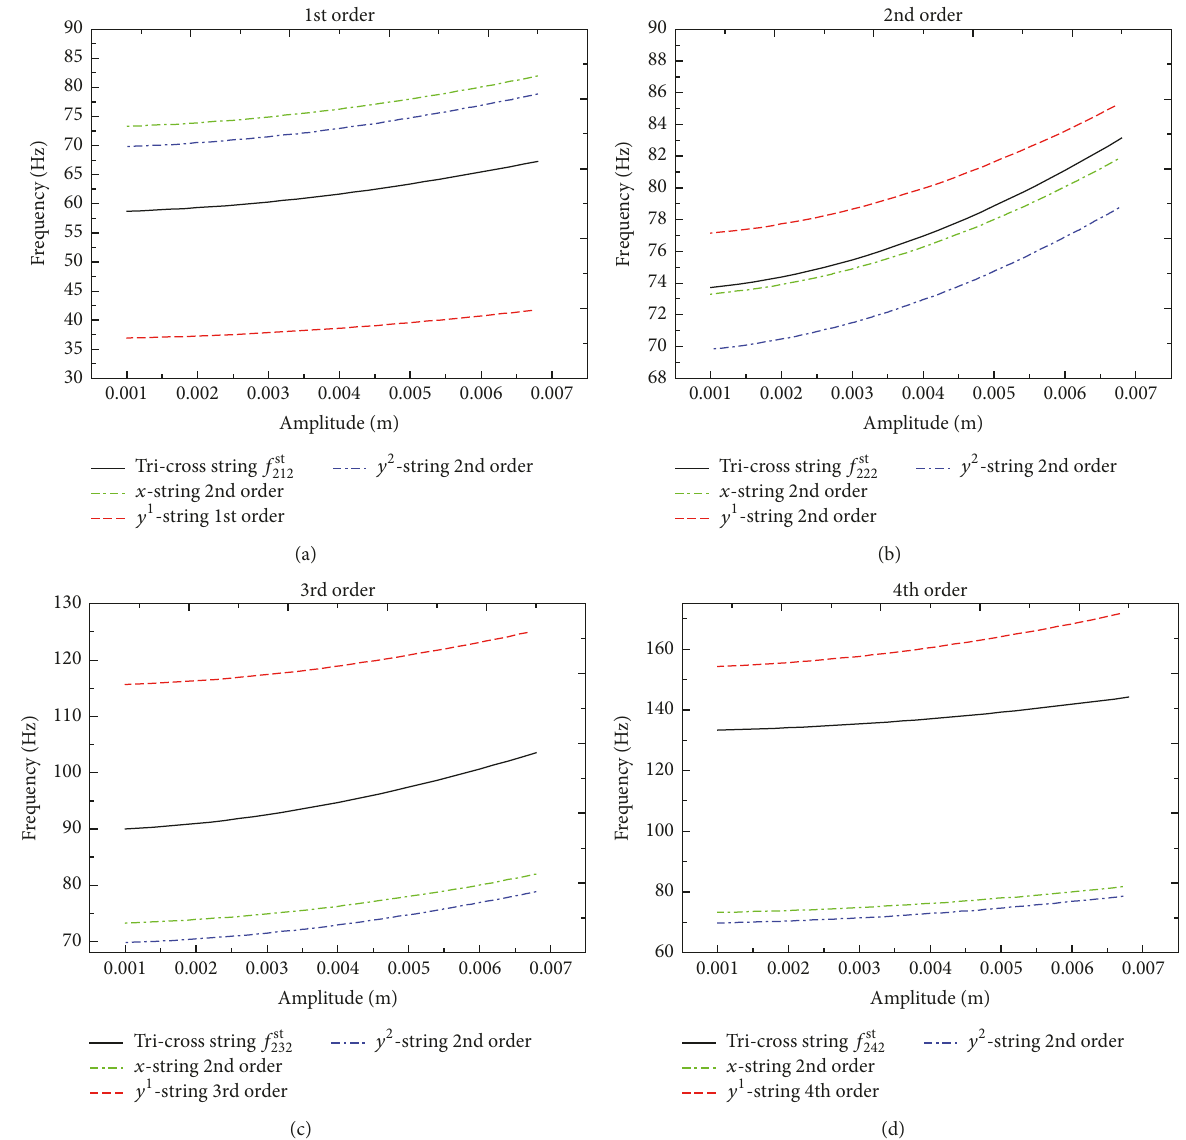
Figure 9: The influence of the vibration amplitude 𝑤 st (𝑥 = 0.5𝑙 0 ,𝑦 1 joint , 𝑦 2 joint , 0) on the first four frequencies of the strings: (a) the first mode 𝑓 st 𝑓 st 𝑓 st 212 , (b) the second mode 222 , (c) the third mode 232 , and (d) the fourth mode